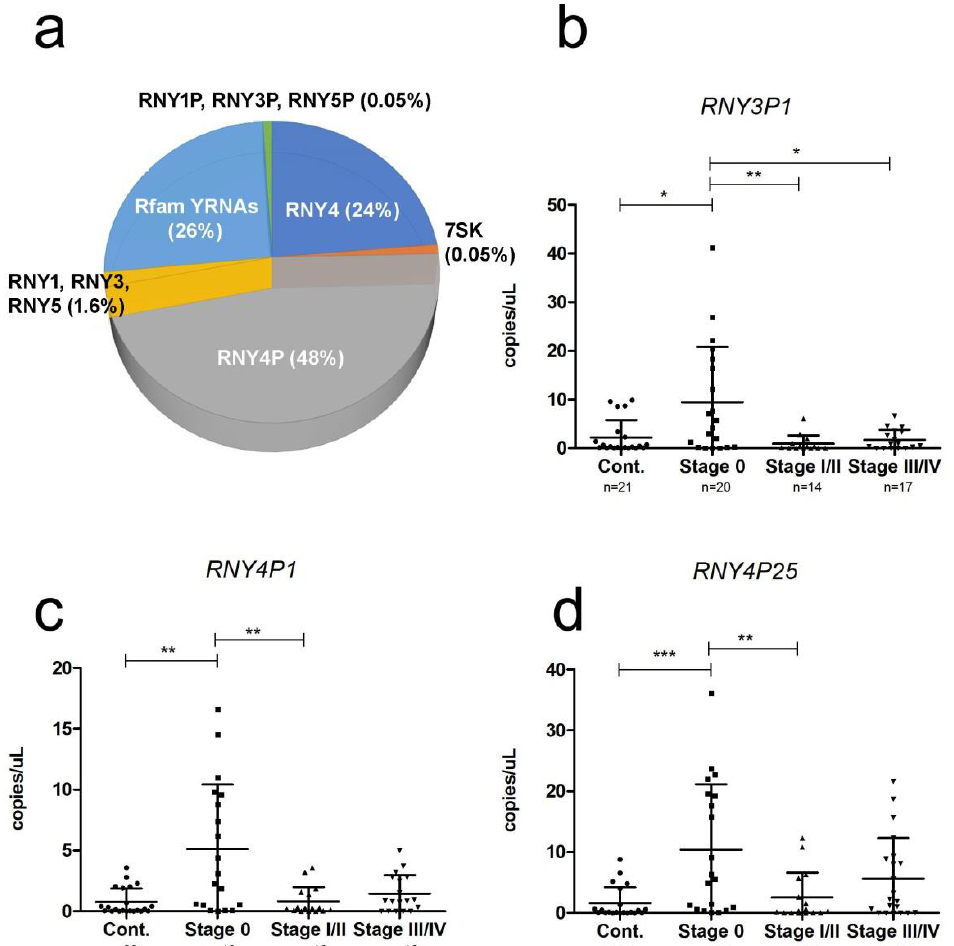
Figure 4. YRNA expression in plasma samples. ( a ) Mean proportions of different YRNA species in NGS cohort plasma samples. Levels of ( b ) RNY3P1 , ( c ) RNY4P1 and ( d ) RNY4P25 measured by ddPCR in an independent validation cohort of 80 plasma samples (22 controls and 58 melanoma patients). Values are shown as absolute copies per µ l. Expression levels were compared using the Kruskal–Wallis multiple comparison test (all the YRNA fragments had p -values of < 0.001), and the Mann–Whitney independent t -test to carry out a pairwise comparison between groups, (* p < 0.5; ** p < 0.01*** p < 0.001).